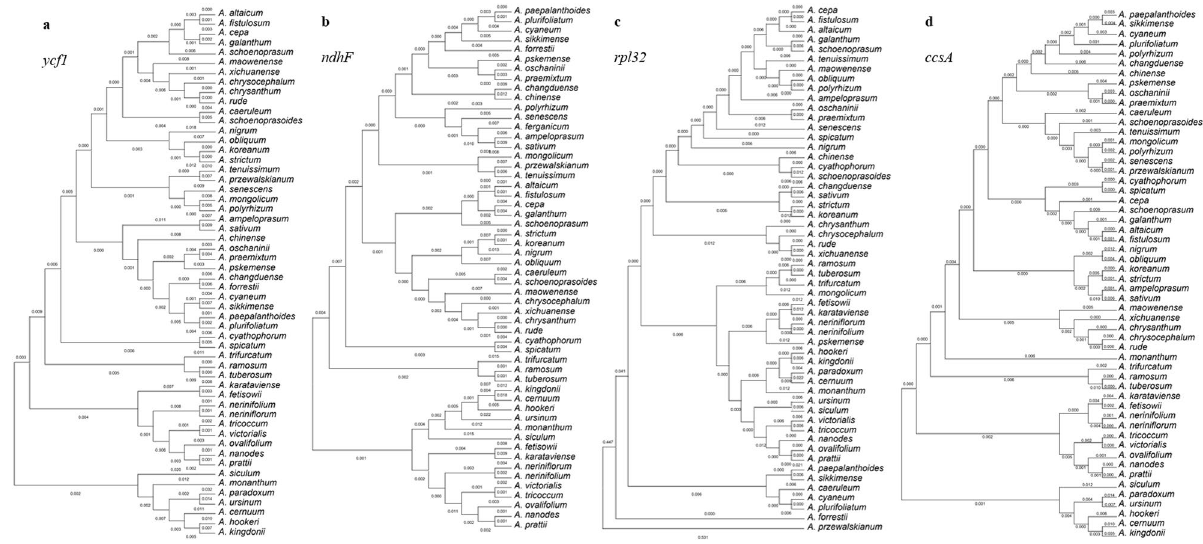
Figure 7. Phylogenetic relationships of four protein-coding genes from 55 Allium species using Maximum Likelihood (ML) analyses. ( A ) ycf1 gene; ( B ) ndhF gene; ( C ) rpl32 gene; ( D ) ccsA